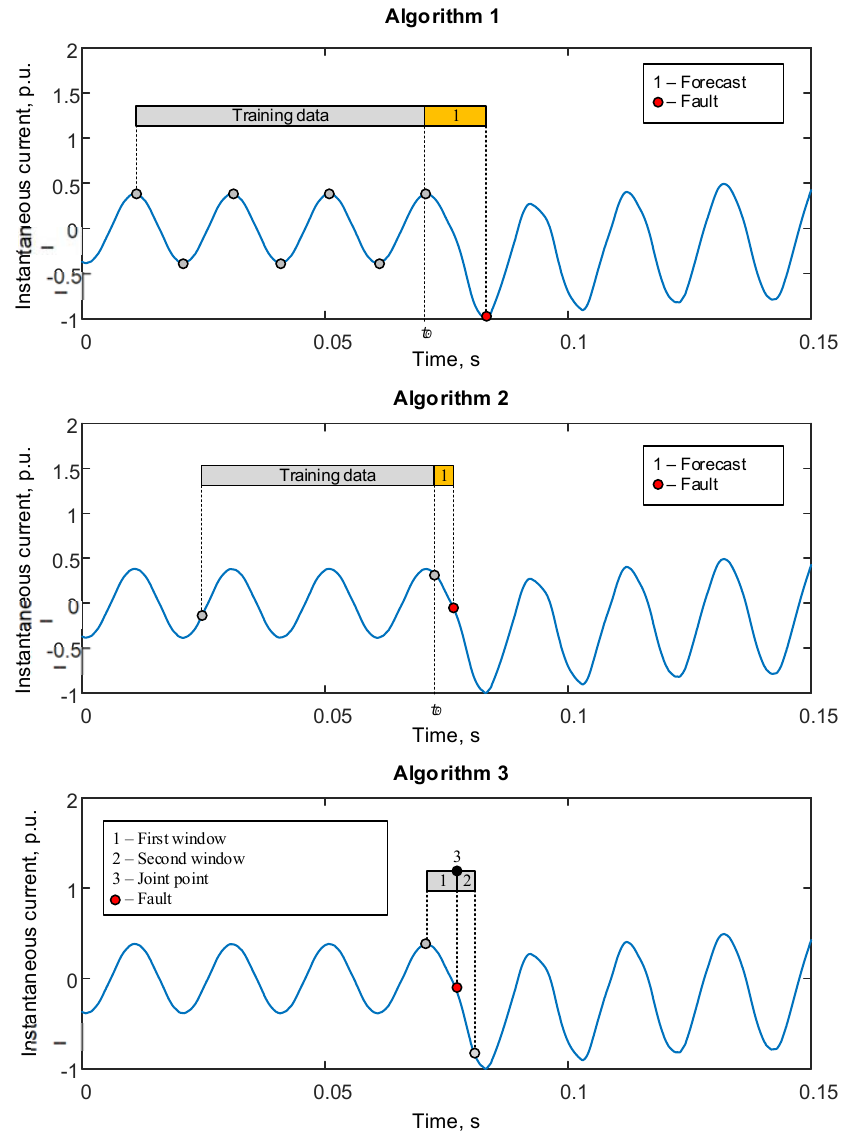
Figure 5. The algorithms time delays for methods of disturbance inception estimation.